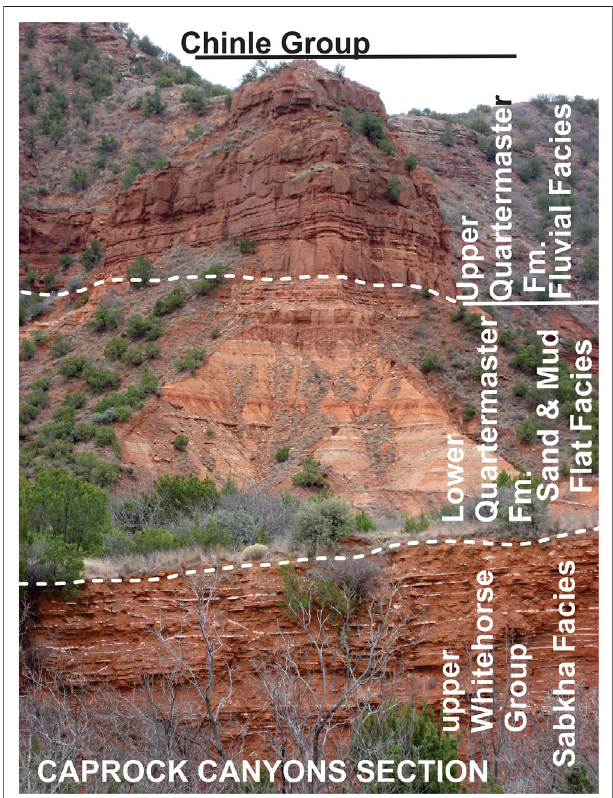
FIGURE 2 | Outcrop photograph of Whitehorse Group and QuartermasterFormationstrataexposedinCaprockCanyonsStateParknear the town of Quitaque, TX U.S.A. The Whitehorse Group strata are equivalent to the salt-lake facies belt (sabkha facies). The lower ∼ 31 m of the Quartermaster Formation make up the sand- fl at facies belt, and the overlying ∼ 75 m of the Quartermaster Formation in this exposure make up the fl uvial facies belt. See text for